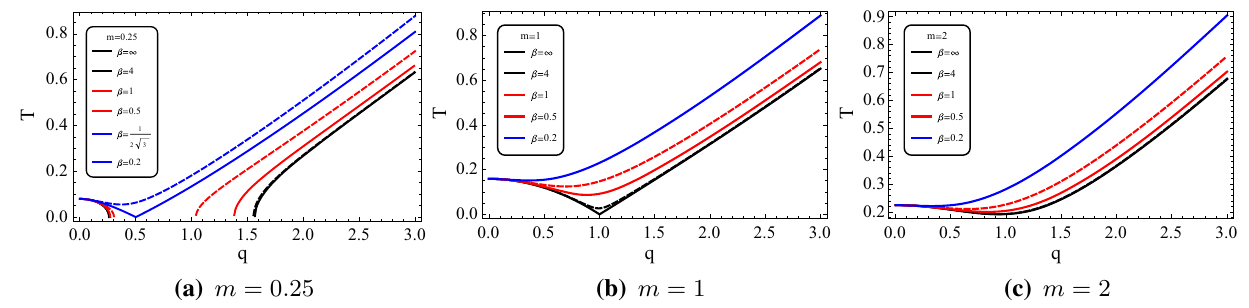
Fig. 6 The behavior of Hawking temperature T for m = 0 . 25, 1 and 2 for nonlinearly charged black